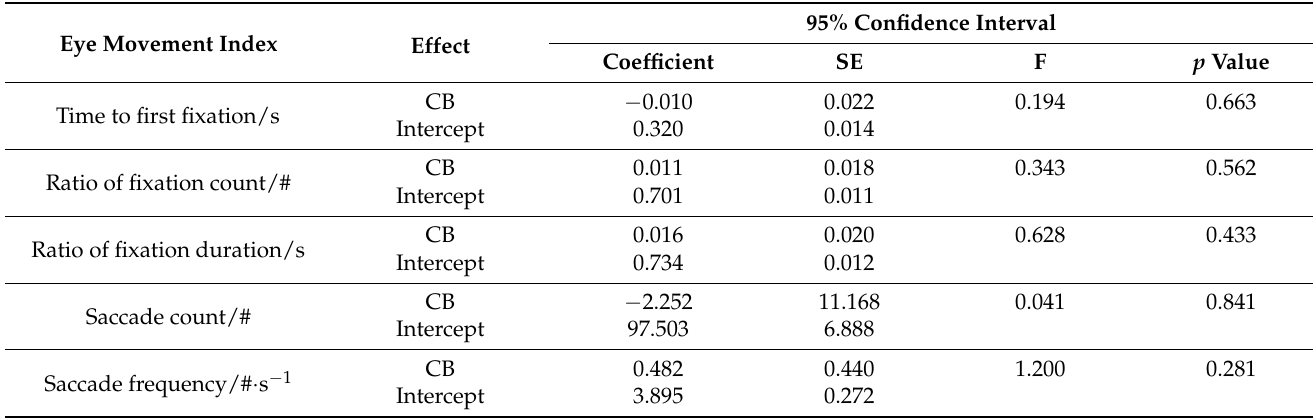
Table A2. Linear mixed model regression results of eye movement data in the spatial visualization task (CB, cultural background; SE, standard error).